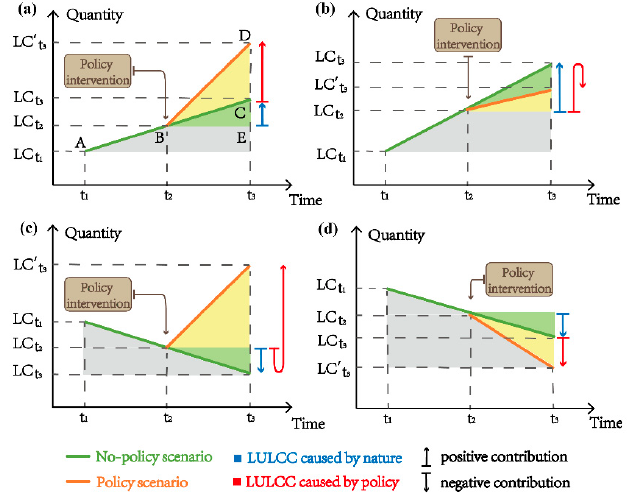
Figure 4. The conceptual diagram used to separate the policy effect on LULCC from the effect of normal background. ( a ) The positive effects of nature and the policy on LULCC. ( b ) The positive effect of nature, while the negative effects of the policy. ( c ) The positive effect of the policy, while the negative effects of nature. ( d ) The negative effects of nature and the policy. LC t is the quantity of each land use and land cover type at time t under the no-policy scenario, LC t 3 is the quantity of each land use and land cover type at time t 3 under the policy scenario. No-policy scenario: a scenario where the LULCC is less affected by the policy. Policy scenario: a scenario where the LULCC is affected by the nature and the policy.